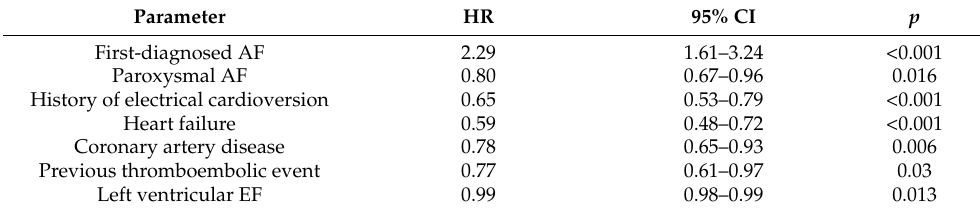
Table 5. Results of multivariable logistic regression analysis—predictors of symptomatic